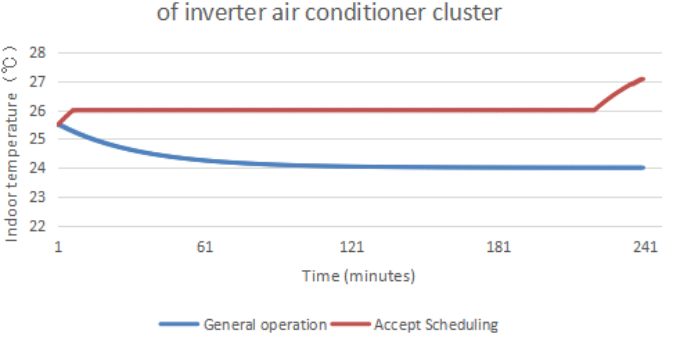
Figure 6. .Contrast of room temperature for 4-h dispatch of inverter air conditioner cluster.